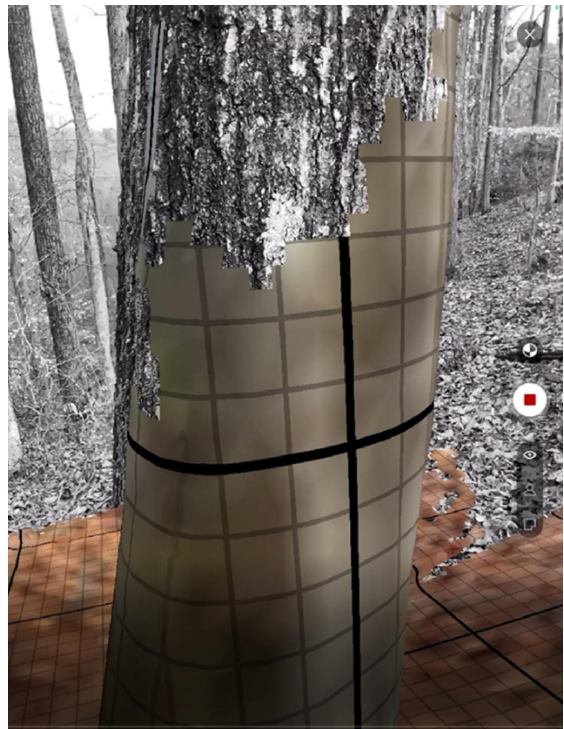
Figure 7. View of Forge application on the iPad Pro while scanning a forest stand.